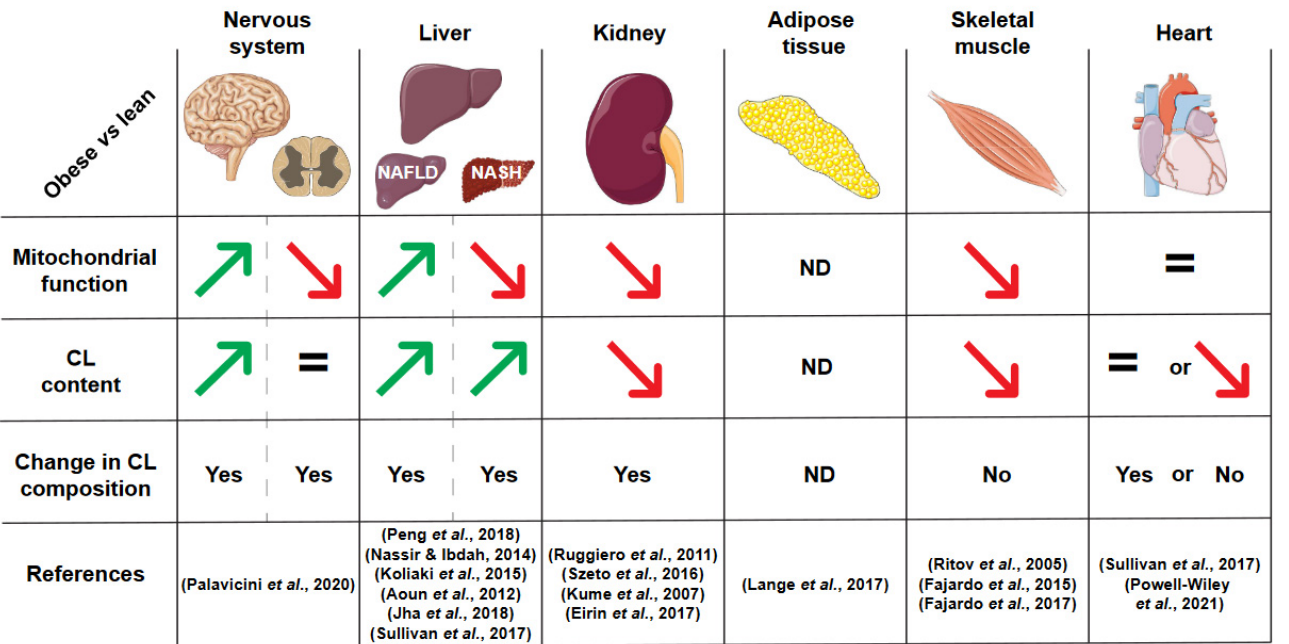
Figure 2. Summary of published alterations of cardiolipin in obese patients or rodents. CL: cardiolipin, NAFLD: non-alcoholic fatty liver disease, NASH: non-alcoholic steatohepatitis, ND: not de-